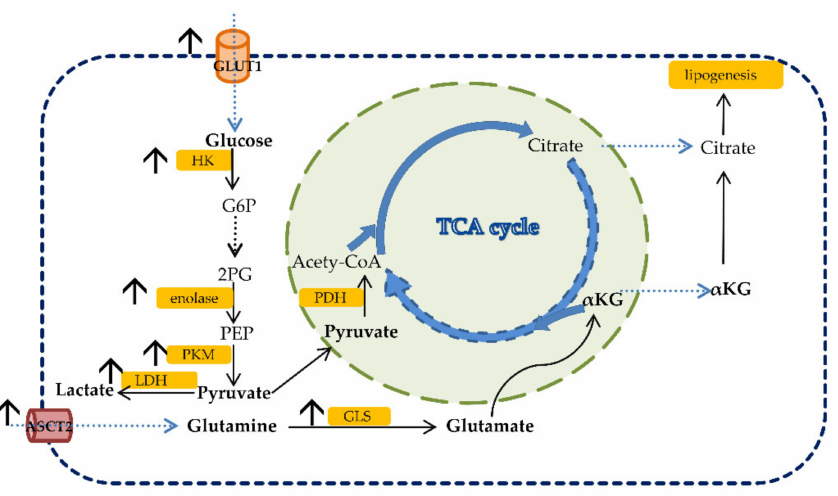
Figure 1. Altered glucose and glutamine metabolism in CRC. Dysregulated enzymes are represented with ↑ indicating upregulation. Glucose is uptaken by the cell through GLUT1 transporter and is further metabolized by different enzymatic reactions. Cancer cells are favoring lactate accumulation through upregulating enzymes such as LDH. Detailed information is provided in the text.2PG: 2-phosphoglycerate; PEP: phosphoenolpyruvate; PDH: pyruvate